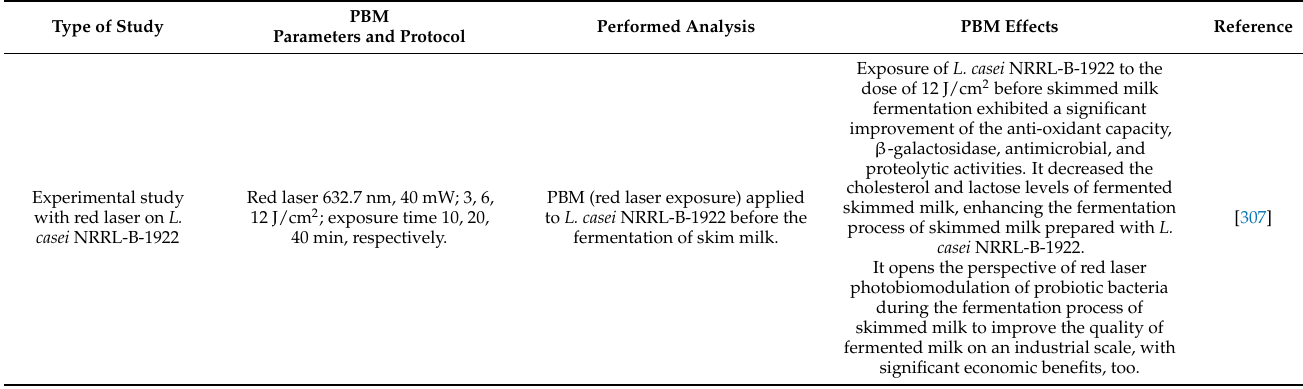
Table 5. Effects of photobiomodulation on microbiome and disease